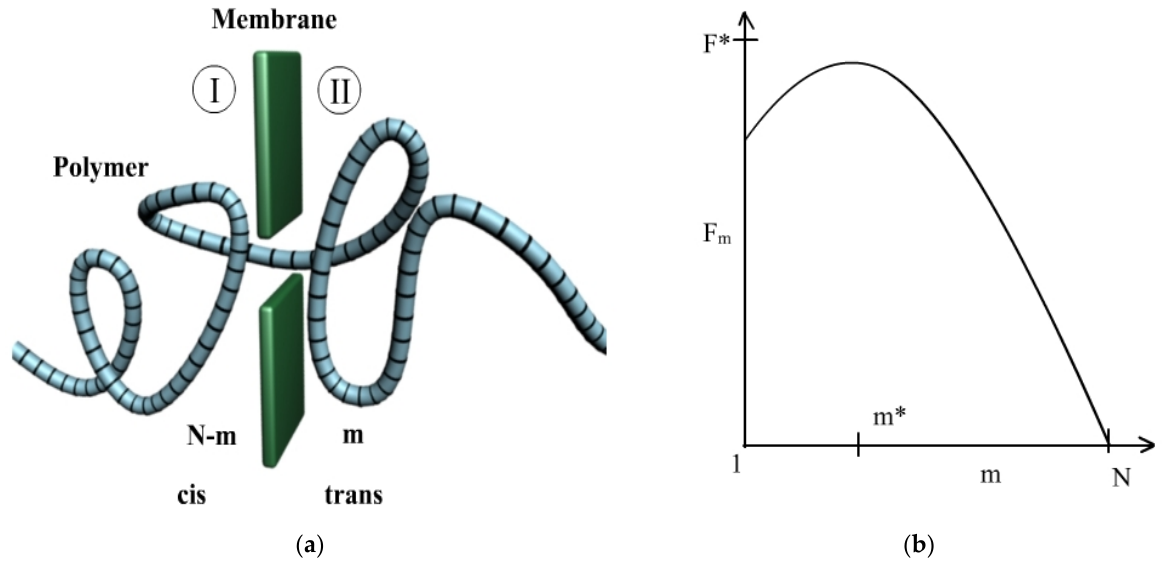
Figure 2. ( a ) Polymer escape in transition, ( b ) Associated free energy barrier ( m segments in region II). m * is the value for which F ( m *) = F *, respectively Fmaxim, meaning the maximum value of the function F , associated free energy